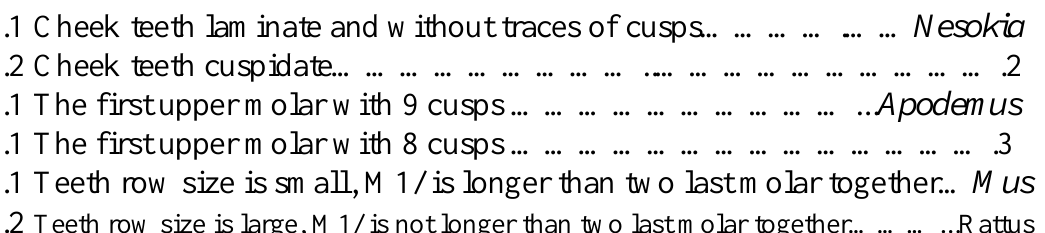
Key to identify the genera of Murinae